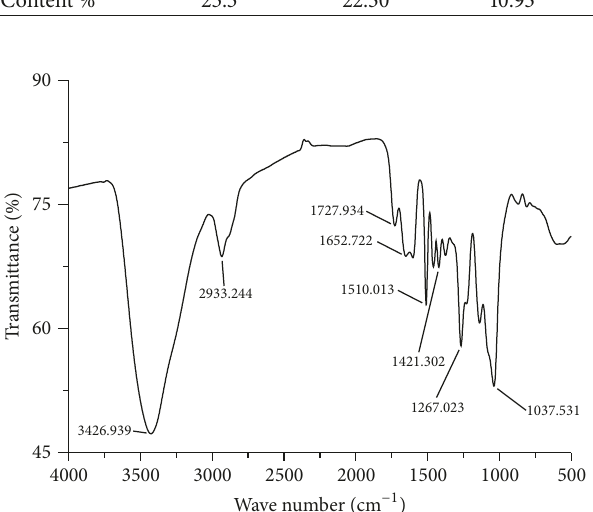
Figure 4: FT-IR spectroscopy of the LCC-based spherical biocarri-